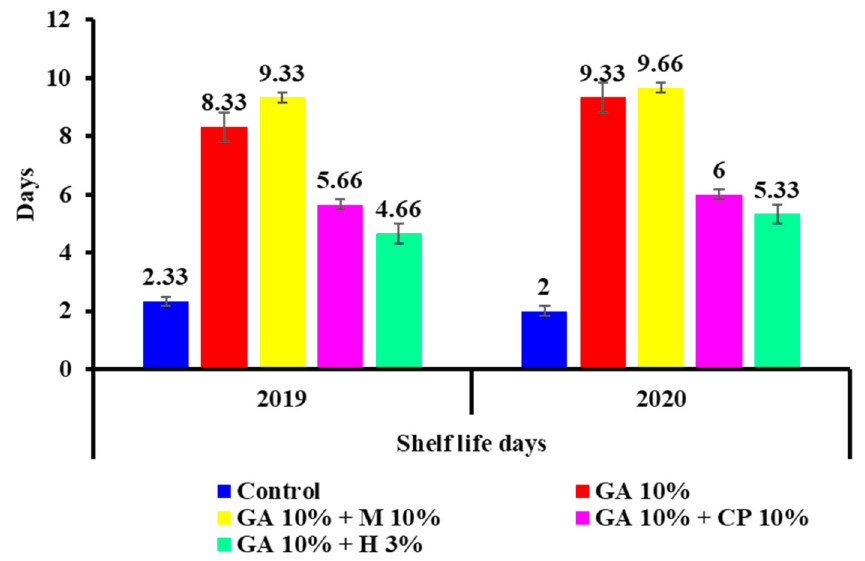
Figure 6. Effect of edible coatings—moringa extract, cactus pear, henna and GA—on shelf life of guava during cold storage.